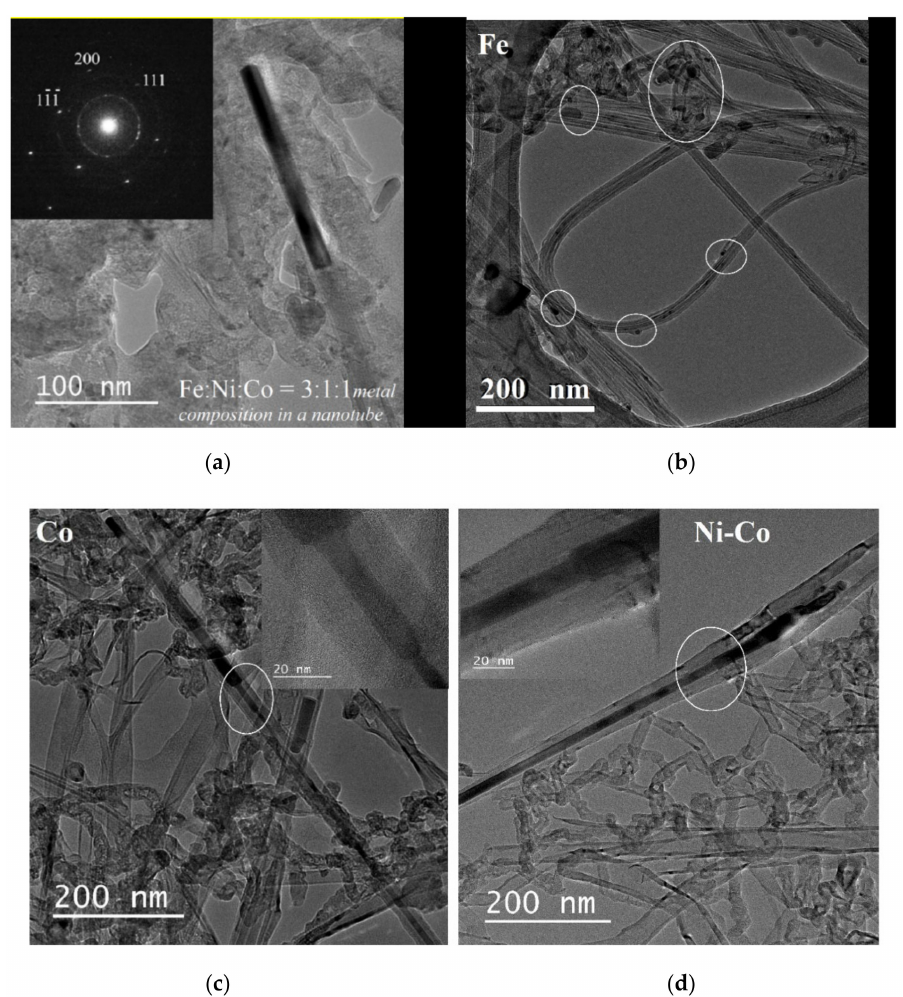
Figure 8. TEM images of the nanotubes with internal metal nanokernels: ( a ) from a mixture of metallocenes Fe-Co-Ni alloy in the growth direction [200] (di ff raction pattern inserted); ( b ) from ferrocene with iron encapsulated in a carbon shell; ( c ) from cobaltocene-segmented nanotubes in the bulk and a Co-filled nanotube with a length of more than 1000 nm; ( d ) from a mixture of Ni-Co metallocenes with a length of more than 1000